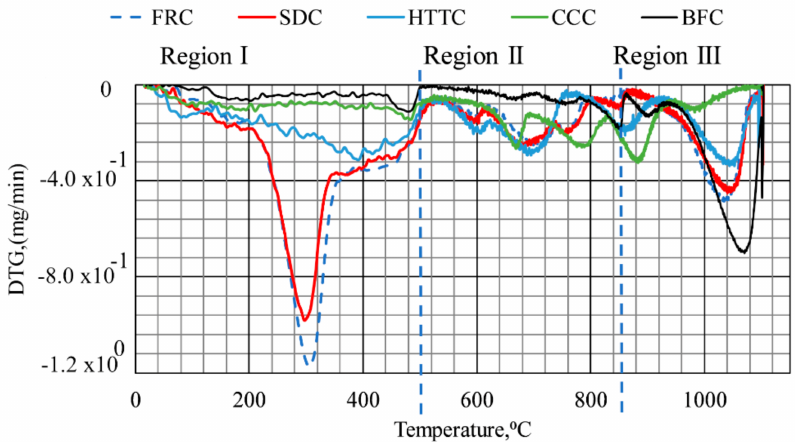
Figure 3. TGA-QMS analysis of self- reducing composites ( a ) FRC; ( b ) SDC; ( c ) HTTC; ( d ) CCC and ( e ) BFC in Argon up to 1100 ◦ C using BF simulated thermal profile.